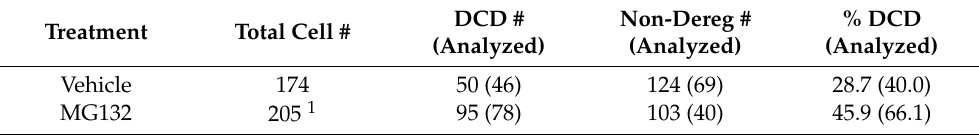
Table 4. Cells undergoing delayed calcium deregulation (DCD) or maintaining Ca 2+ homeostasis (Non-dereg) in the absence and presence of the proteasome inhibitor MG132 ( # or %, as indicated). Numbers in parenthesis in the table refer only to the analyzed cells within each